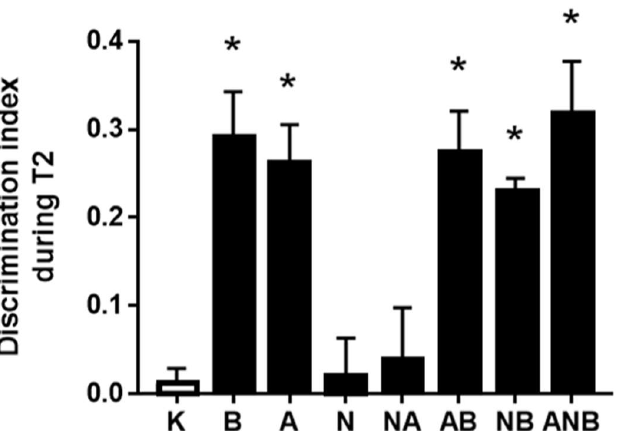
Figure 1. Discrimination index D expressed by different groups of rats during T2. The discrimination index D in the novel object recognition test for ketamine-induced disorder in T2, mean values, and 95 percent confidence intervals are presented. The application protocol was injected ip immediately after T1. 1h ITI was used. In ketamine rats (3 mg/kg ip), medication (mg/kg ip) was: L-NAME (5) (N), L-arginine (100) (A), BPC 157 (0.01) (B), alone and/or together (L-NAME+L-arginine (NA), L-arginine+BPC 157 (AB), L-NAME+BPC 157 (NB), L-arginine+L-NAME+BPC 157 (ANB)), and saline 5 mL/kg ip (control ketamine) (K). The application was immediately before ketamine (L-NAME, L-arginine, and combination) or the application was immediately after ketamine (BPC 157 and combinations). Dunnett’s multiple comparison test was used to compare control group (K) with treated groups. * p < 0.05 relative to ketamine.